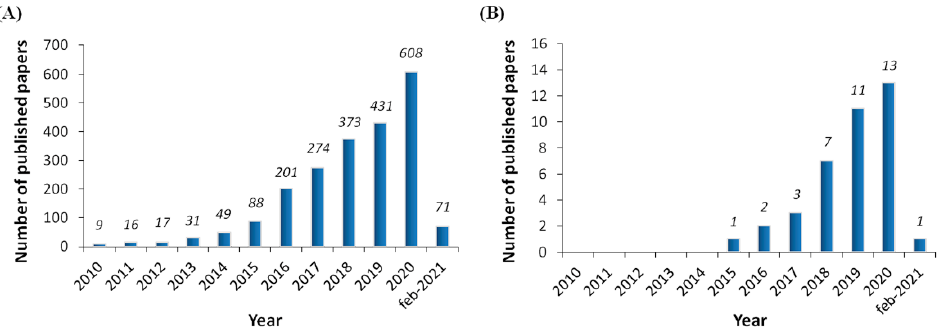
Figure 1. Histogram showing the timeline of publications (number per year), from the PubMed website, using the key “3D bioprinting” ( A ), and “eye/ocular/cornea/retina 3D bioprinting” ( B ) (updated to 2 February 2021).